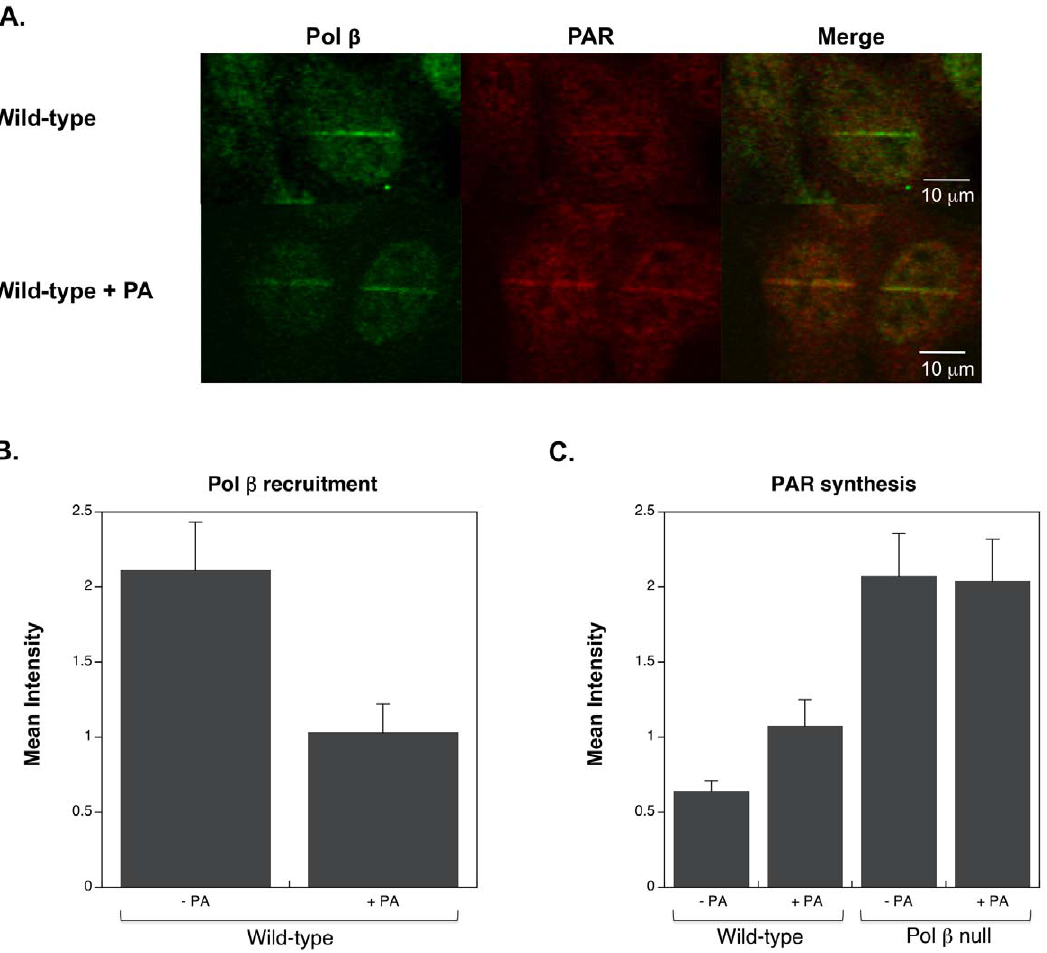
Figure 4. Effect of PA on recruitment of pol b and PAR synthesis. A. Images one minute after irradiation in wild-type cells, and wild-type cells treated with 300 m M PA. B. Pol b recruitment one minute after irradiation in the absence and presence of PA. C. PAR synthesis at the site of damage one minute after irradiation in the absence and presence of PA. Images are representative; at least five cells were measured for every time point and error bars reflect